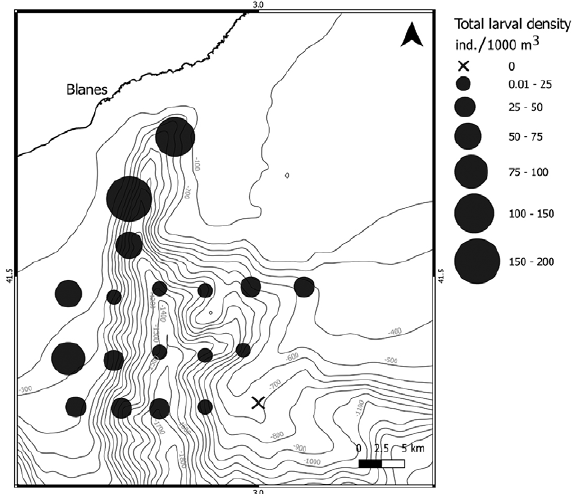
Fig. 4. – Total decapod larvae density in individuals (ind.) per 1000 m 3 for